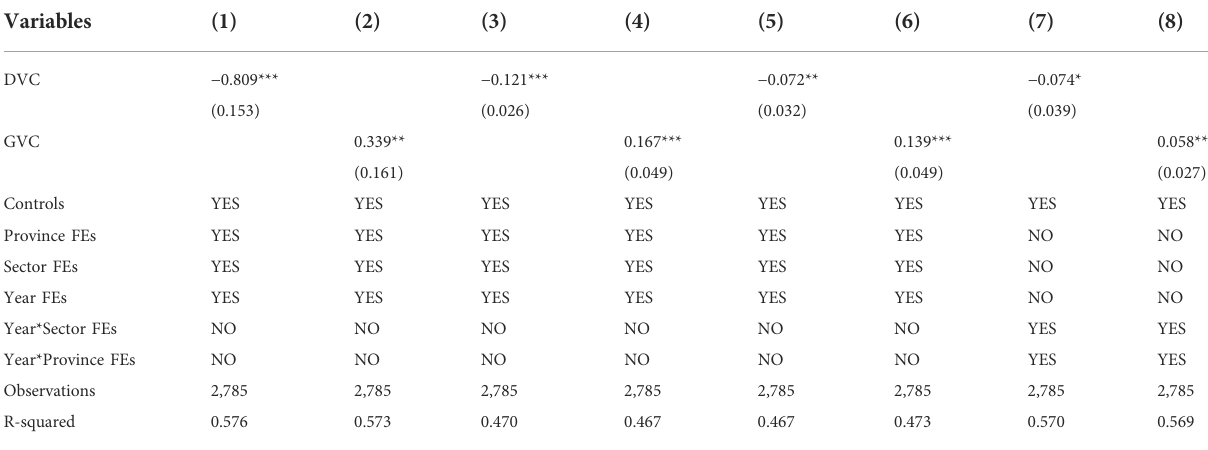
TABLE 4 Robustness regression